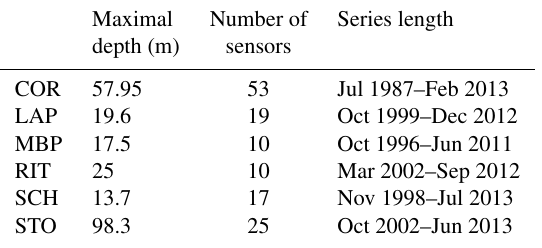
Table 1. Maximal depth, number of temperature sensors and series length of the boreholes used for